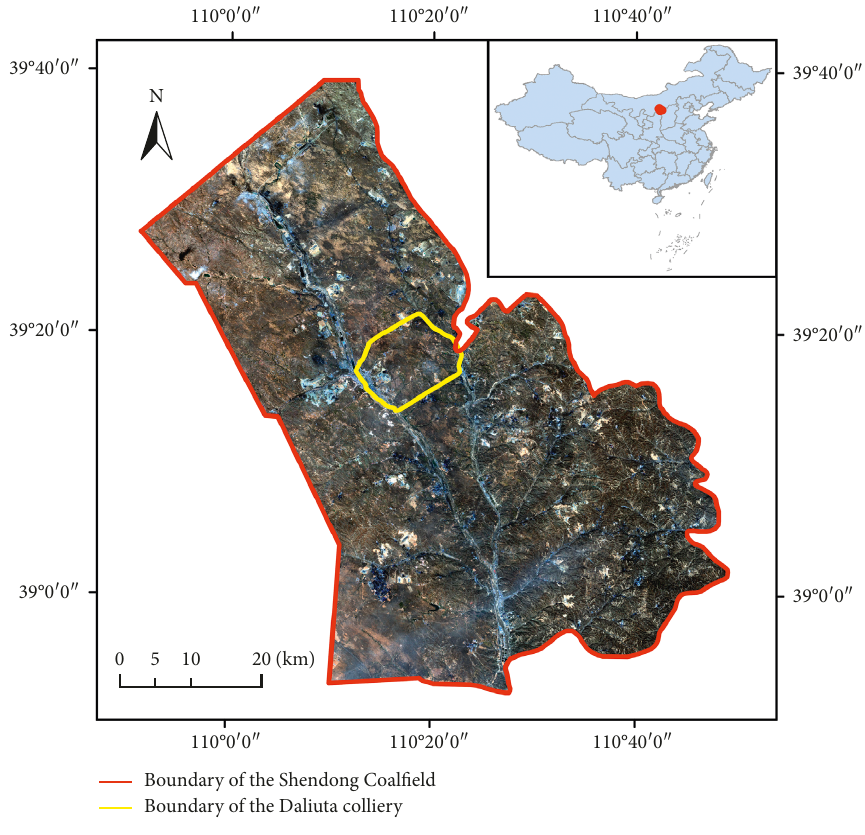
Figure 2: Location of the Shendong